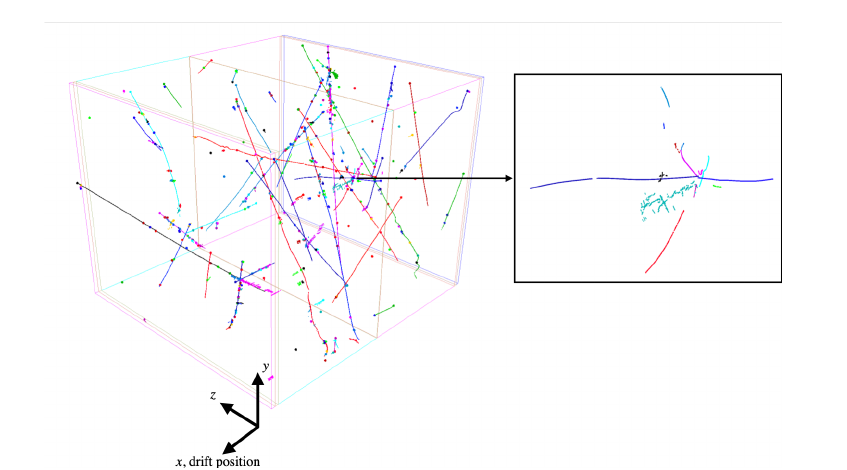
Figure 7. Pandora [14] reconstruction of cosmic rays and beam interaction in a ProtoDUNE-SP event. The left side of the figure shows the full detector volume with all interactions, including cosmic rays and the right side shows the identified beam interaction.